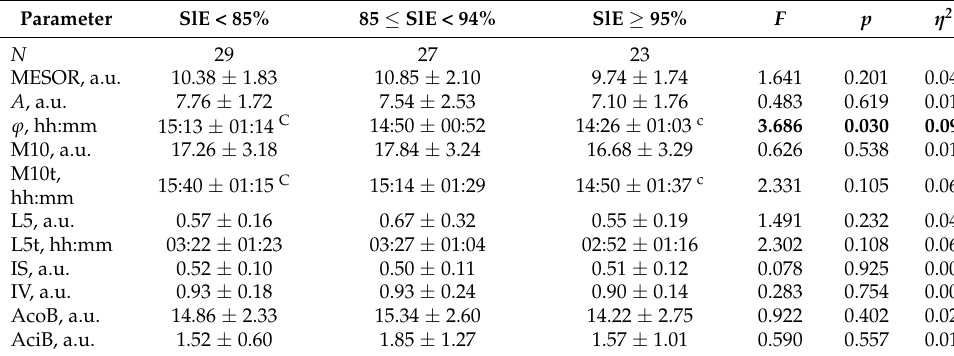
Table 6. Association of sleep efficiency with 24 h rest–activity rhythm